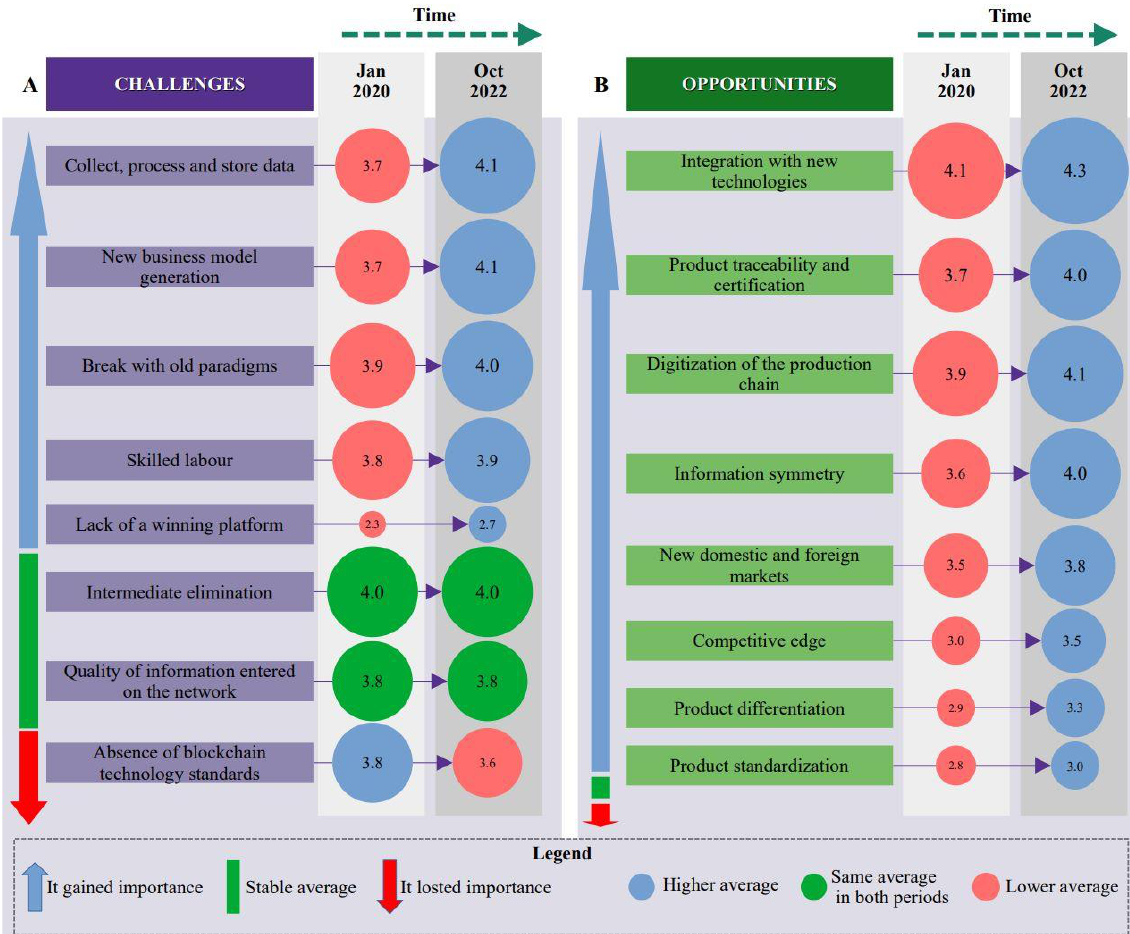
Figure 3. Changes in perceptions of the challenges ( A ) and opportunities ( B ) of applying blockchain technology in agribusiness. Source: prepared by the authors based on survey data.